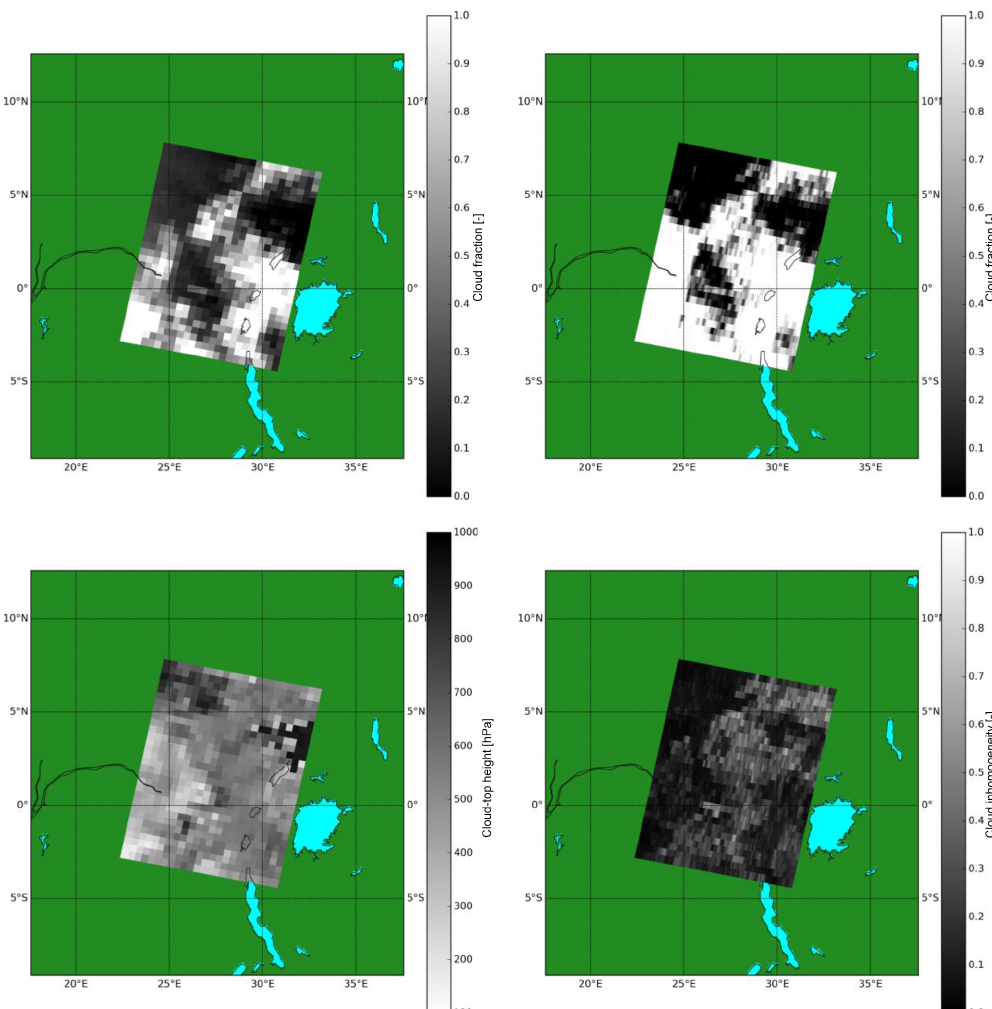
Figure 14. FRESCO + effective (or radiometric) cloud fraction (upper left panel) and the AVHRR-derived cloud fraction (upper right panel) for sample data for GOME-2 Metop-A from March 2015. Also shown are the FRESCO + cloud top height (lower left panel) and the AVHRR- derived inhomogeneity (lower right